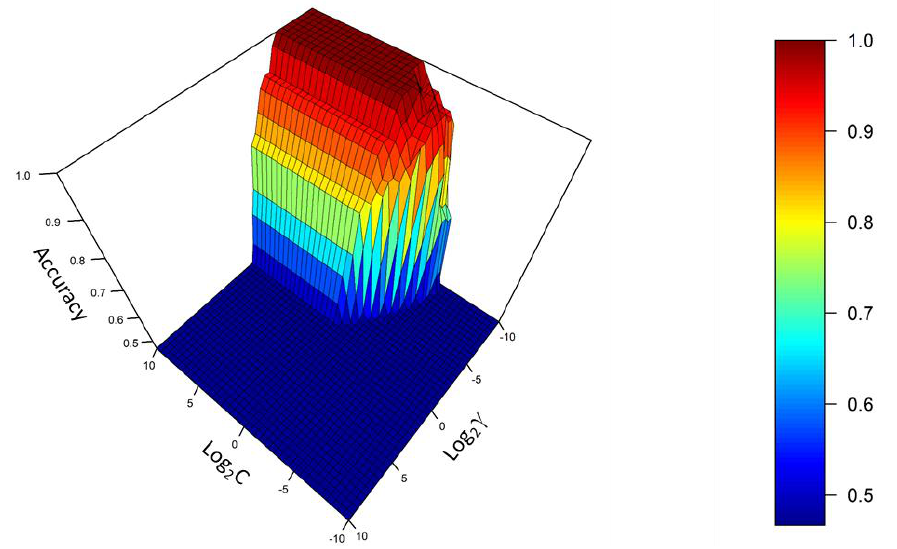
Figure 3. Accuracy of the SVM model calculated using k-fold cross-validation according to log 2 C and log 2 γ values.